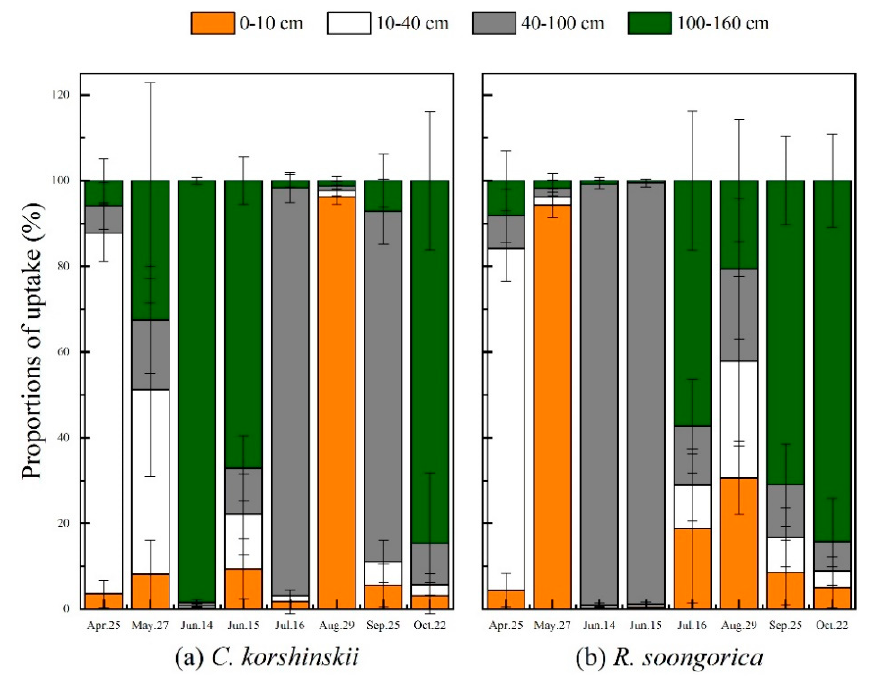
Figure 8. Seasonal variations in fraction of water uptake from different soil layers based on MixSIAR for ( a ) C. korshinskii and ( b ) R. soongorica . (Mean ± S.D., N = 4).